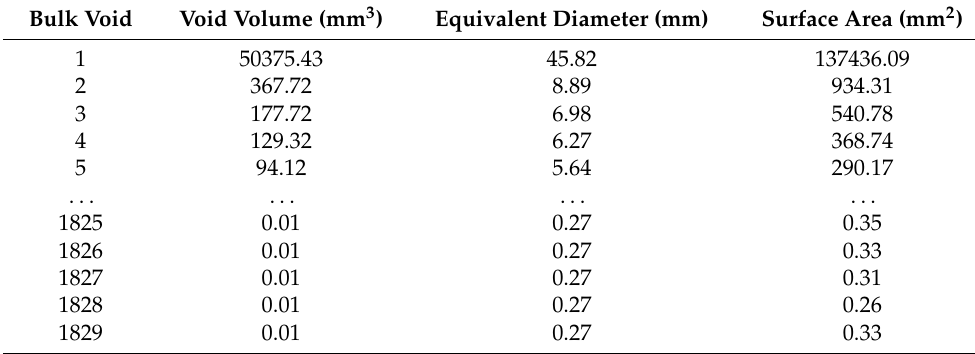
Table 8. Characteristic parameters of bulk voids in EPA-13 with 5.1% asphalt content.